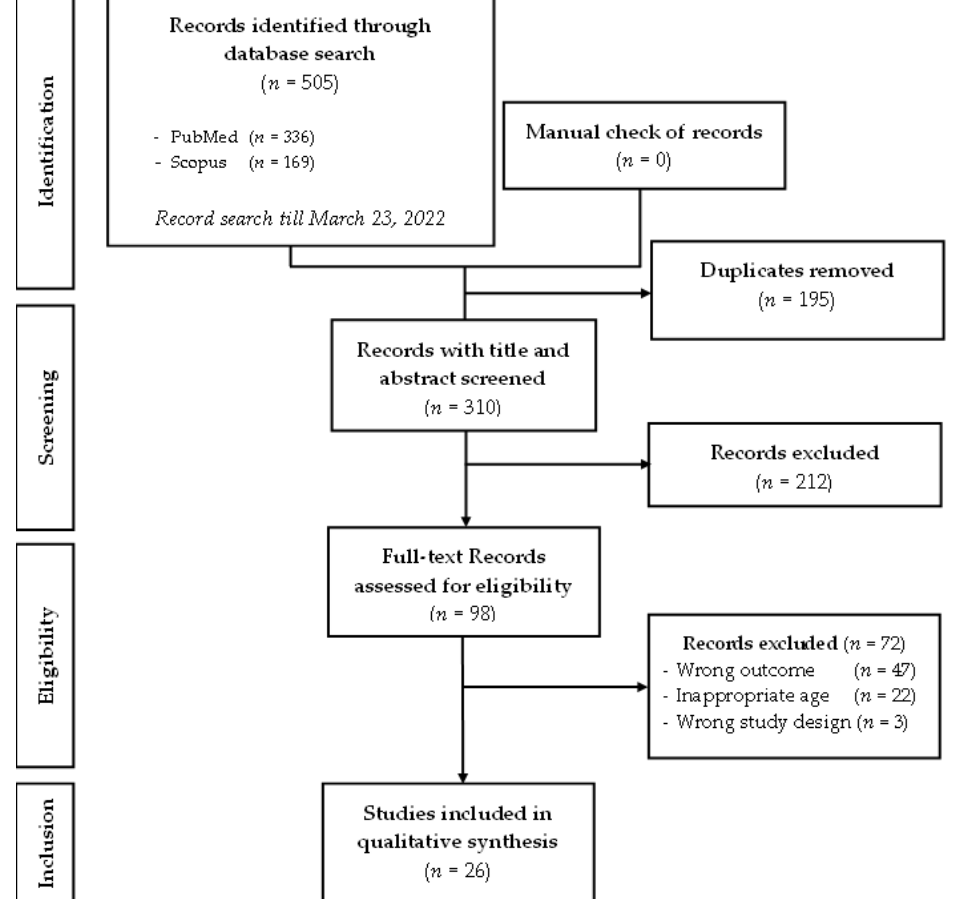
Figure 1. PRISMA flow diagram of the records included in the systematic review.